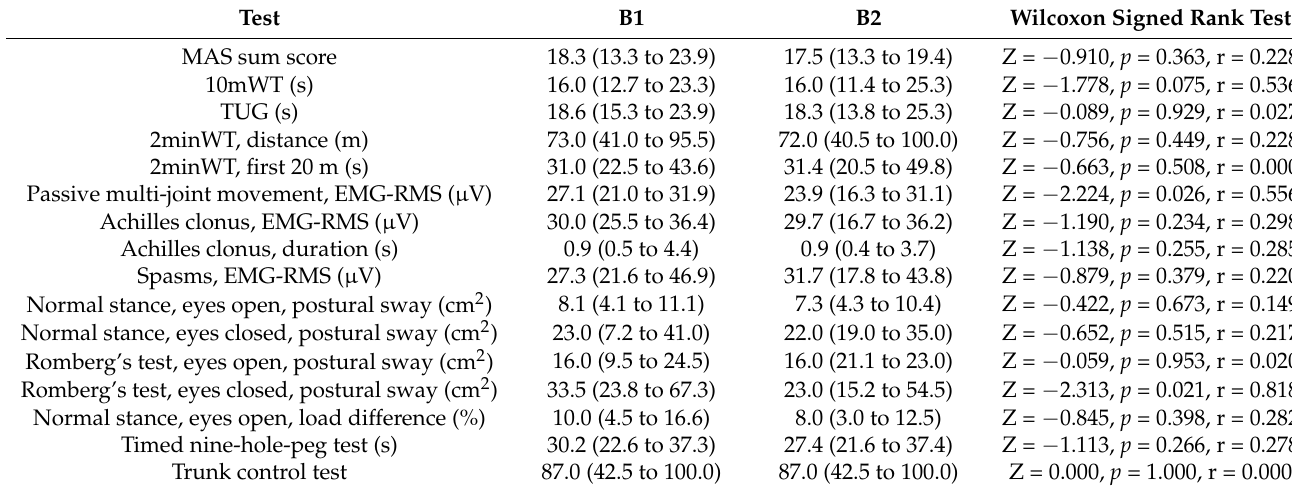
Table A2. Group results and statistical comparisons of tests conducted in assessments I1 and I2.